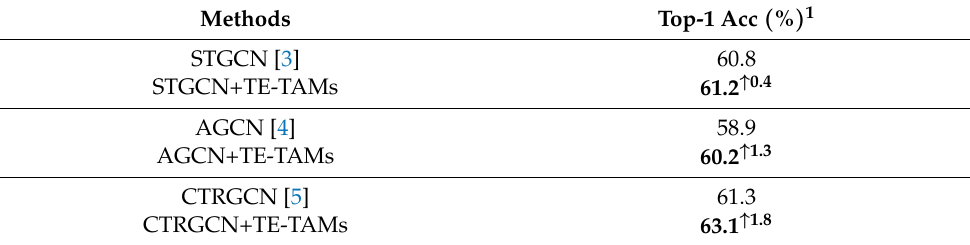
Figure 6. Training process. Training loss, Top-1 Accuracy, and Top-5 Accuracy of AGCN, STGCN, and CTRGCN with and without TE-TAM. Table 4. Comparison of accuracy for three GCN-based models with and without TE-TAM